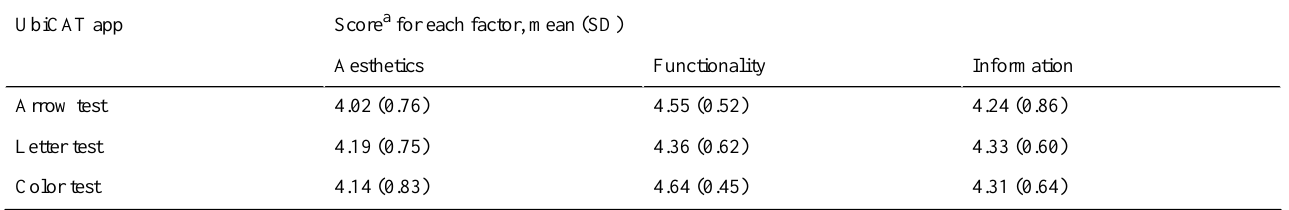
Table 5. Usability ratings of the UbiCAT (Ubiquitous Cognitive Assessment Tool)